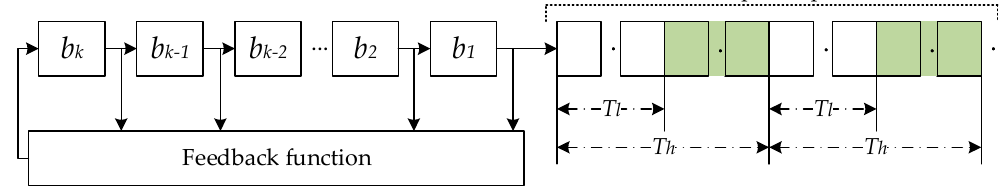
Figure 6. The migration trigger mechanism.